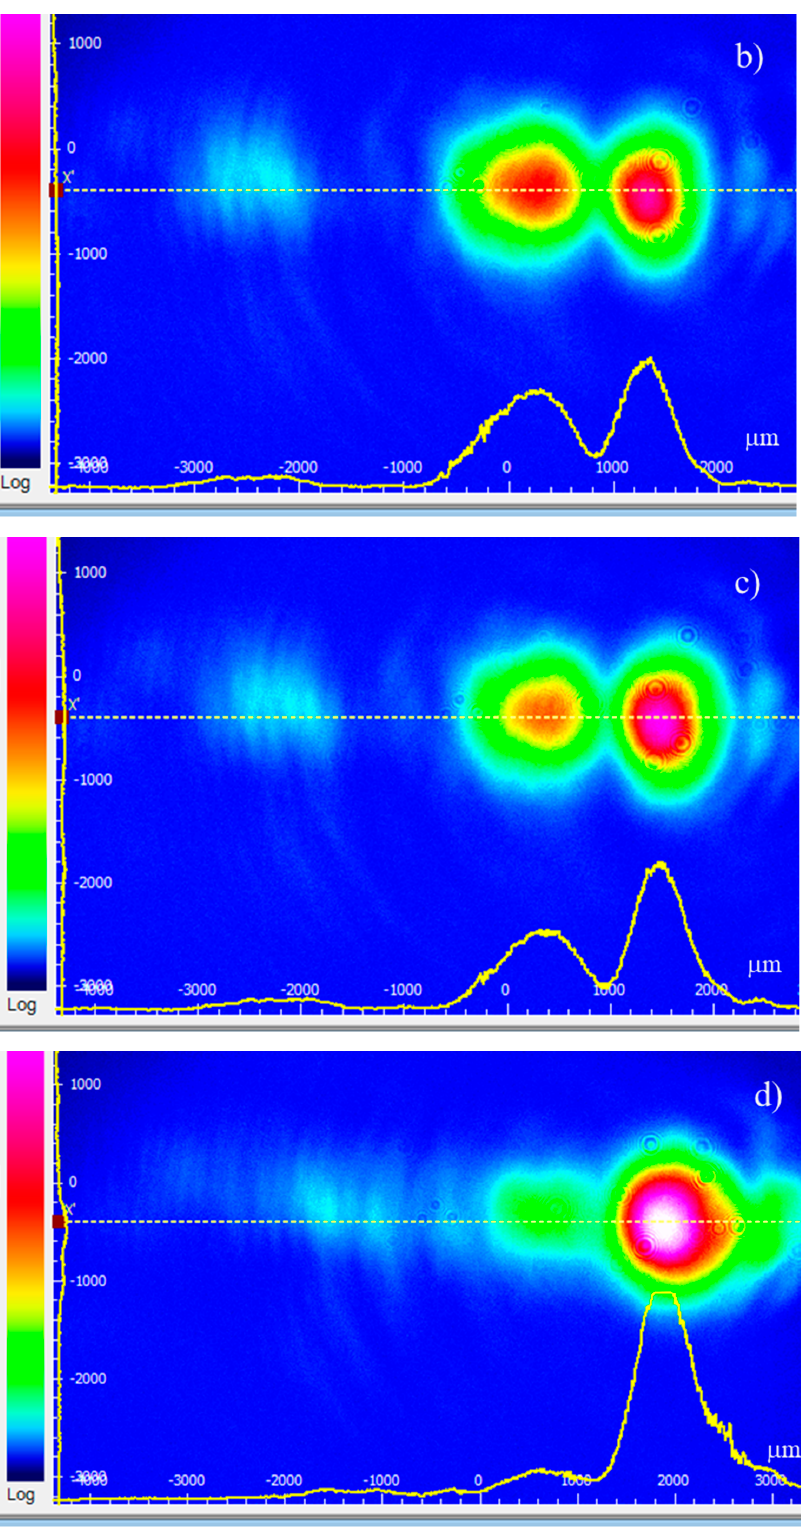
Figure 14. Measured intensity profiles of the reflected beams from the Ni grating with a period of Λ = 400 nm and depth of h = 80 nm at a distance z = 11 cm. ( a ) θ i = 33.47 ◦ ; ( b ) θ i = 33.53 ◦ ; ( c ) θ i = 33.58 ◦ ; ( d ) θ i = 33.73 ◦